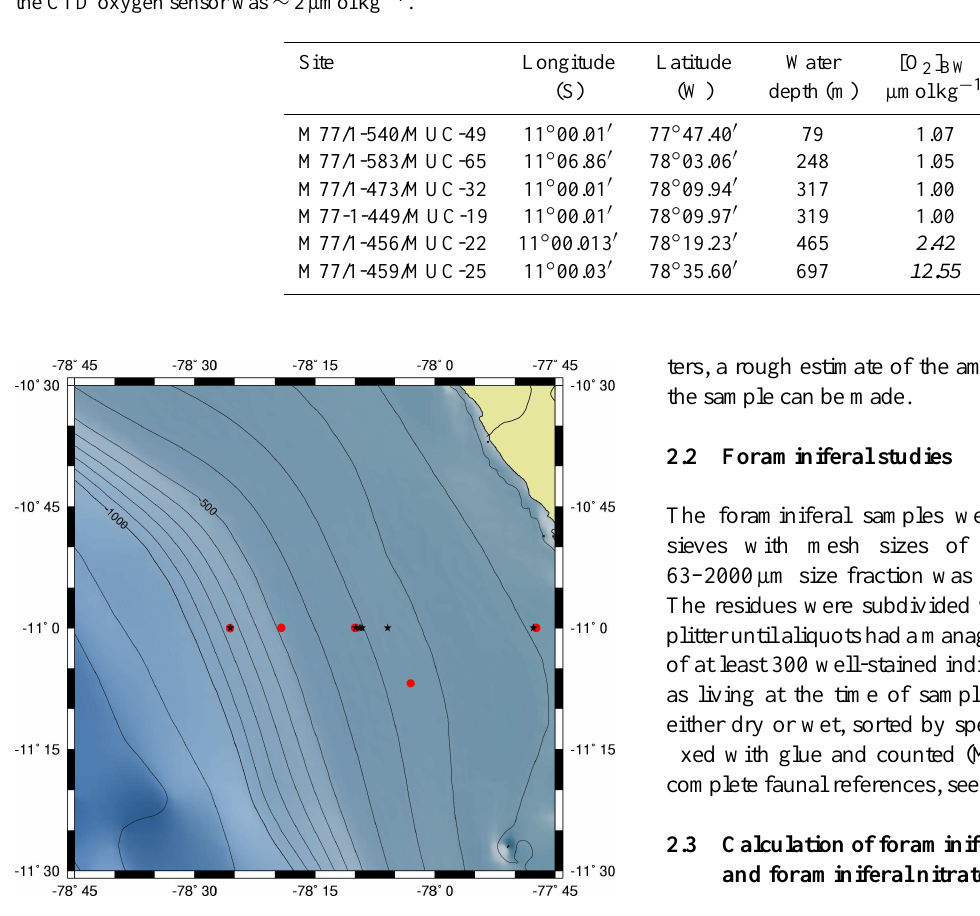
Figure 1: Map of sampling sites. Red circles: Foraminiferal studies and pore water profiles; Fig. 1. Map of sampling sites. Red circles: foraminiferal studies Black stars: Lander sites for in situ flux data. Note that at the 79, 319 and 697 m sites consistent datasets are available for foraminifera, pore-water profiles and lander data (three and pore water profiles; black stars: lander sites for in situ flux lander and two foraminifera repititions on different days for the 319 m site). At 248 m the data. Note that at the 79, 319 and 697m sites, consistent datasets MUC site for foraminiferal studies and pore water profiles is about 0°07´ south of the are available for foraminifera, pore water profiles and lander data corresponding lander station. (three lander and two foraminifera repetitions on different days for the 319m site). At 248m the MUC site for foraminiferal studies and pore water profiles is about 0 ◦ 07 0 south of the corresponding lander